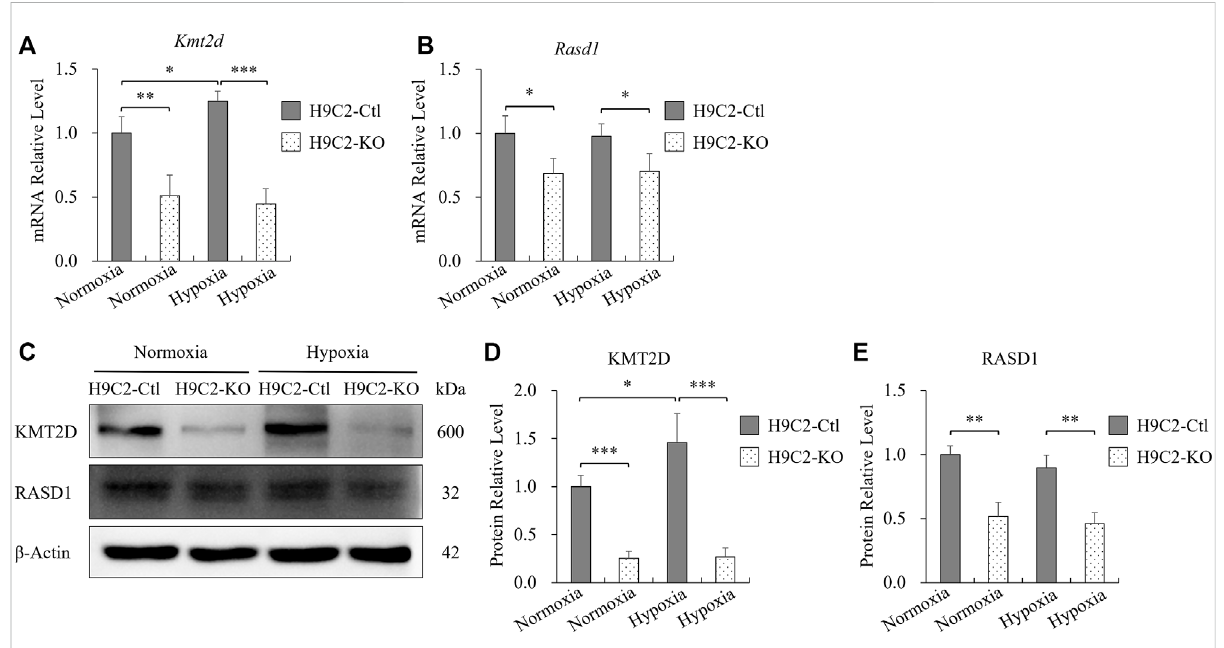
FIGURE 5 The expression of Rasd1 in H9C2 cells was not affected by hypoxia. (A,B) qPCR analysis for Kmt2d (A) and Rasd1 (B) in hypoxia in H9C2-Ctl and H9C2-KO cells. (C) Representative images of western blots for KMT2D and RASD1 expression in normoxia/hypoxia conditions in the H9C2-Ctl and